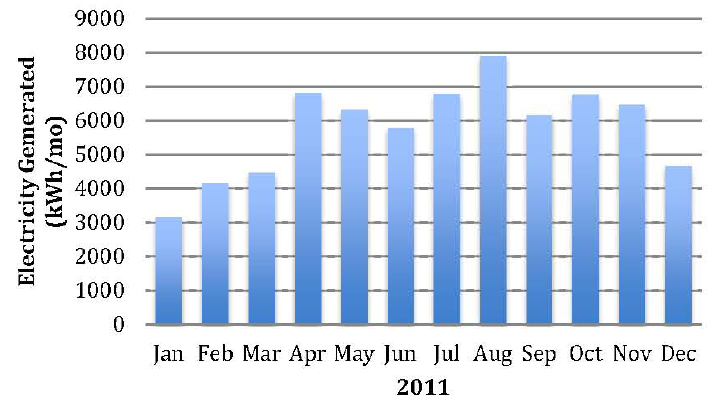
Figure 5. Electricity generated at the Shenzhen IBR (2011).